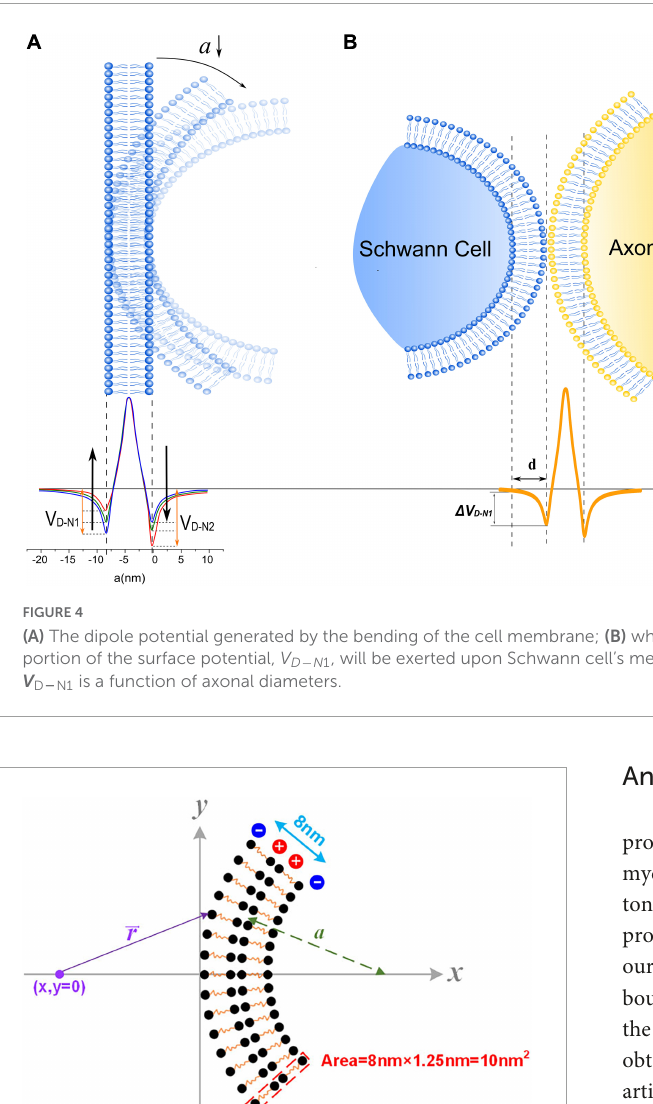
FIGURE5 The modeling details of the calculation of the cell membrane’s dipole potential.